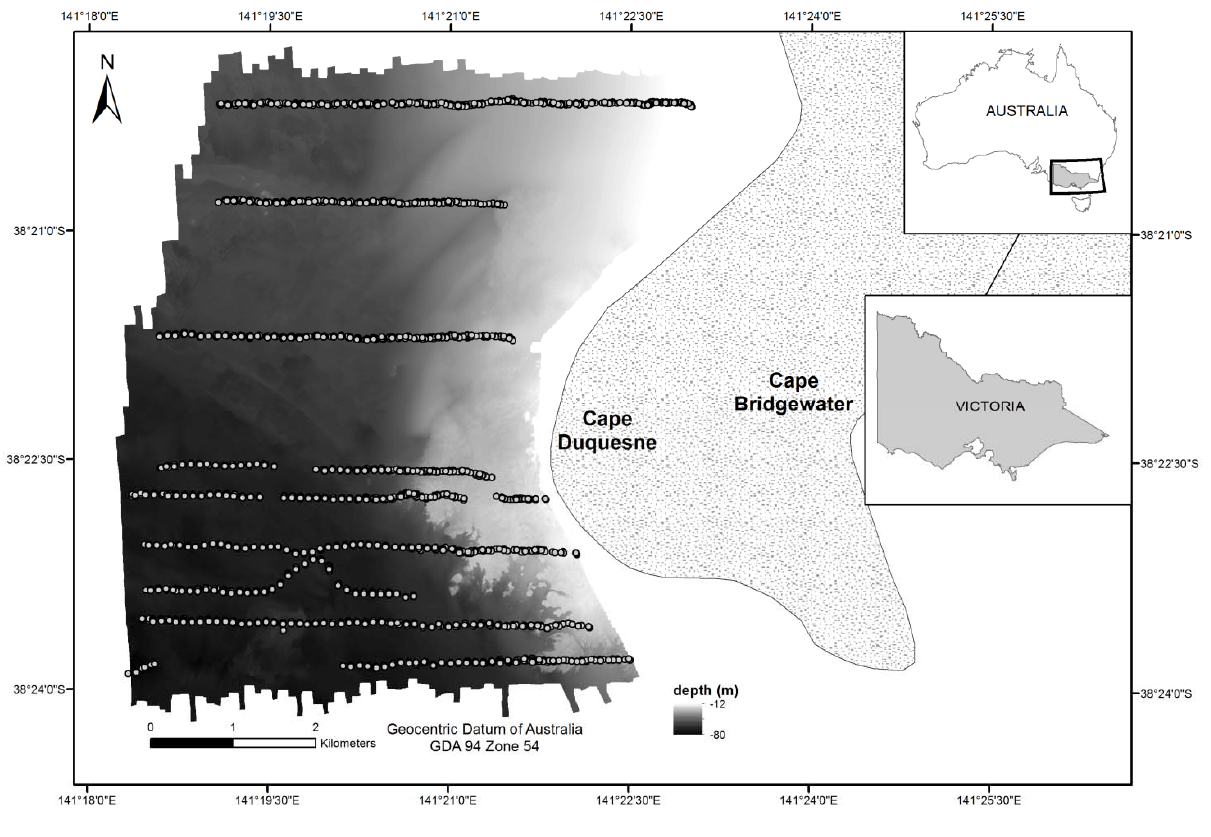
Figure 1. Bathymetric map from multibeam echo sounder survey of the study area. The grey circles represent the ground truth data from georeferenced towed underwater video